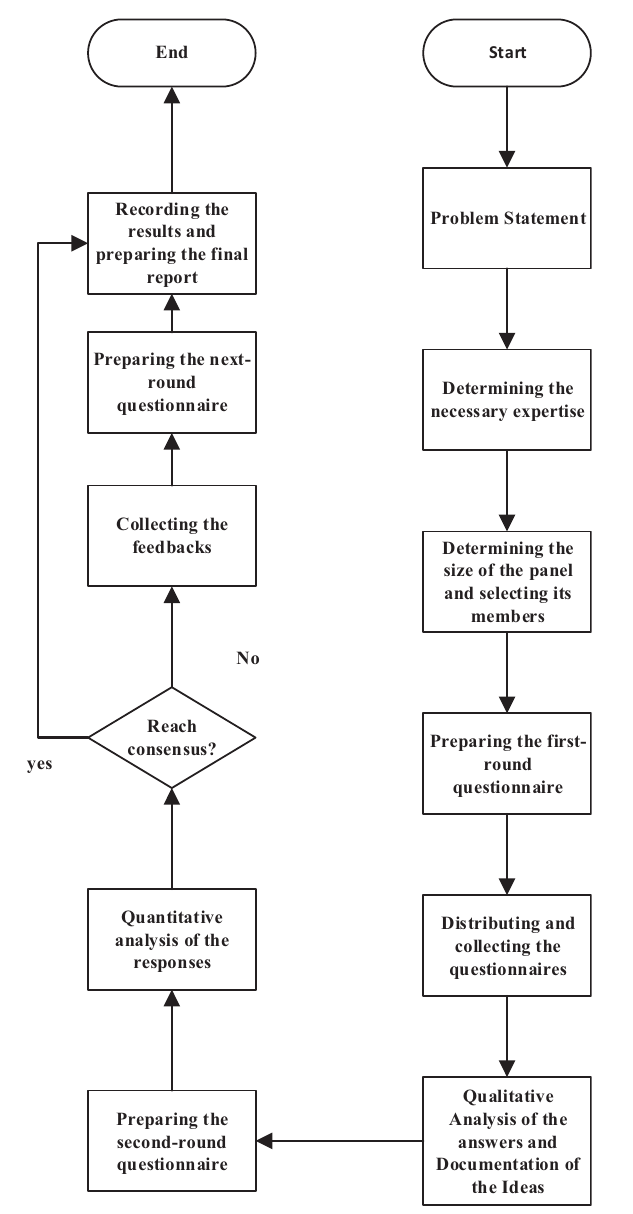
Figure 4. The Delphi